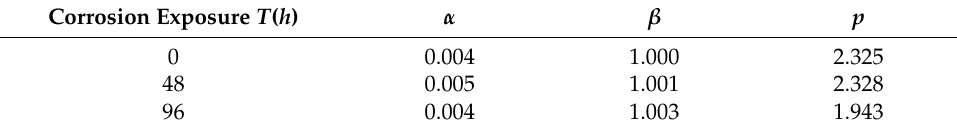
Figure 5. Schematic diagram of inverted S-shaped fatigue damage model. Table 1. Identified damage parameters for specimens with different corrosion times.